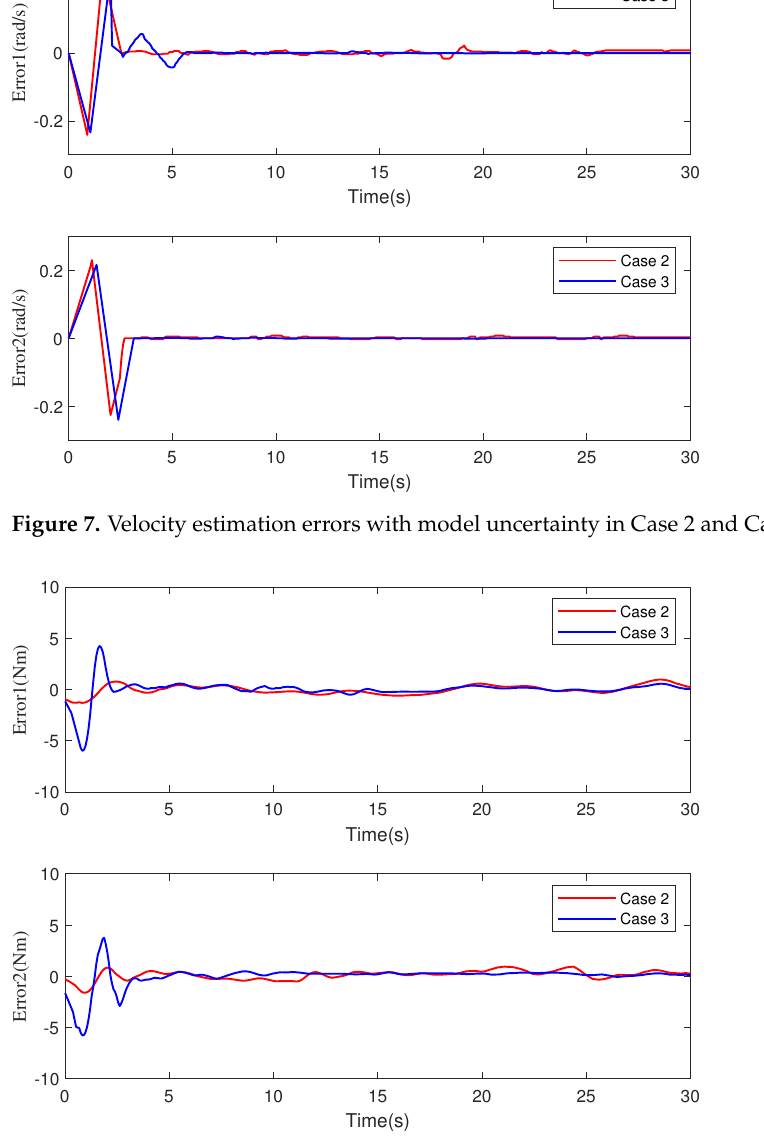
Figure 8. Uncertainty estimation errors with model uncertainty in Case 2 and Case